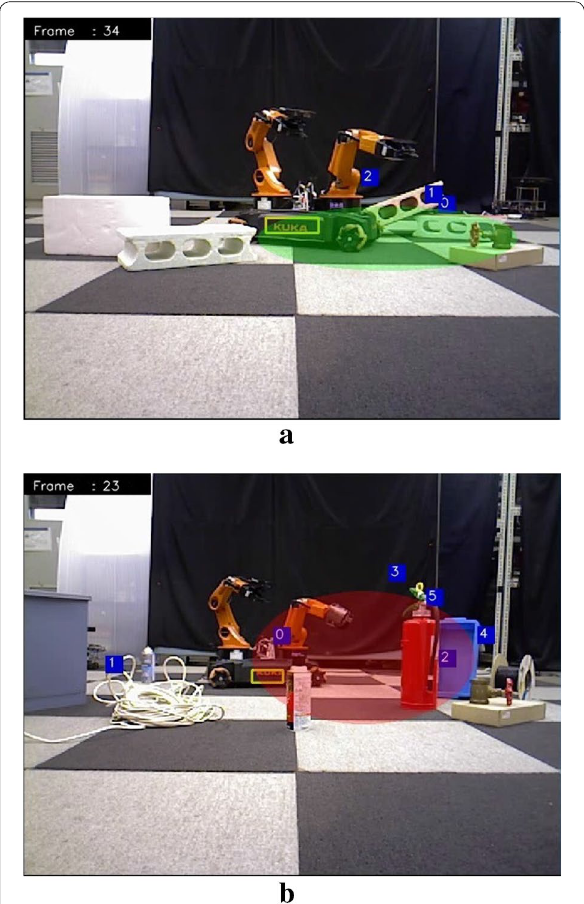
Fig. 11 State of danger warning under each condition. a Warning of danger under case A, b warning of danger under case B